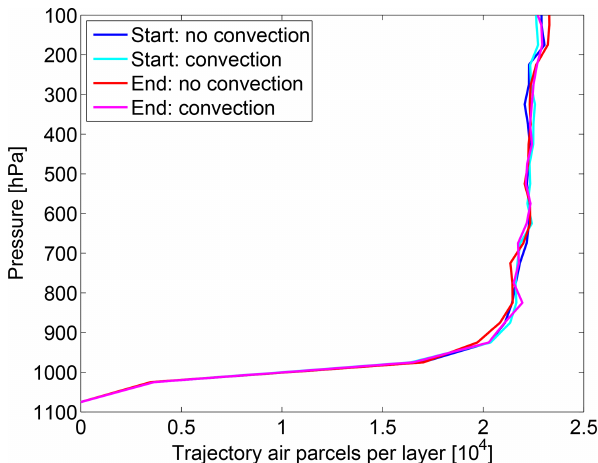
Figure 13. Long-time conservation of the vertical mass distribution after 15 years for a run with forward trajectories using the constant convective area fraction profile and for a run without convection. We show the number of trajectory air parcels in 50hPa bins at the start of the run (blue and cyan) and at the end of the run (red and magenta).